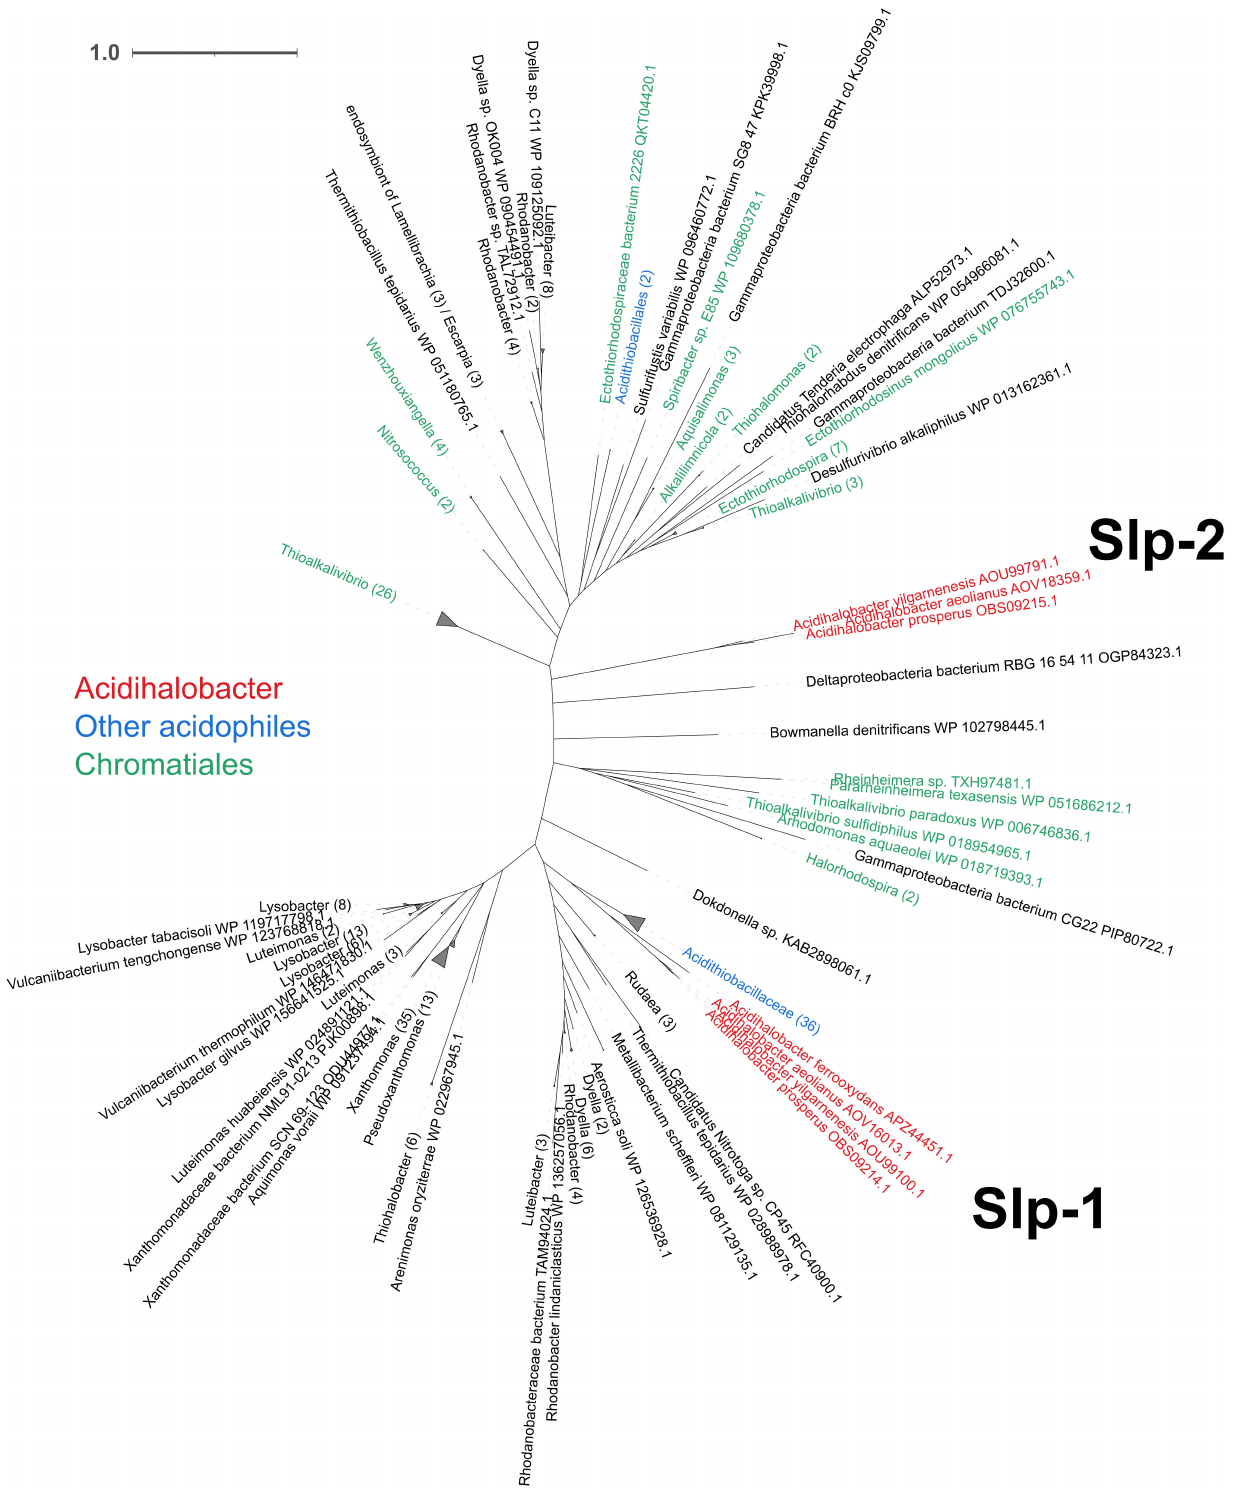
FIGURE 4 | Unrooted phylogenetic tree of the predicted Acidihalobacter Slp amino acid sequences and their best hits from the NCBI non-redundant database, with collapsed branches by genera when possible (showing in parenthesis the number of leaves inside each). Acidihalobacter Slp proteins are colored red, Chromatiales proteins are colored green and other acidophiles proteins are colored blue. The time scale bar represents 1 amino acid substitution per site.